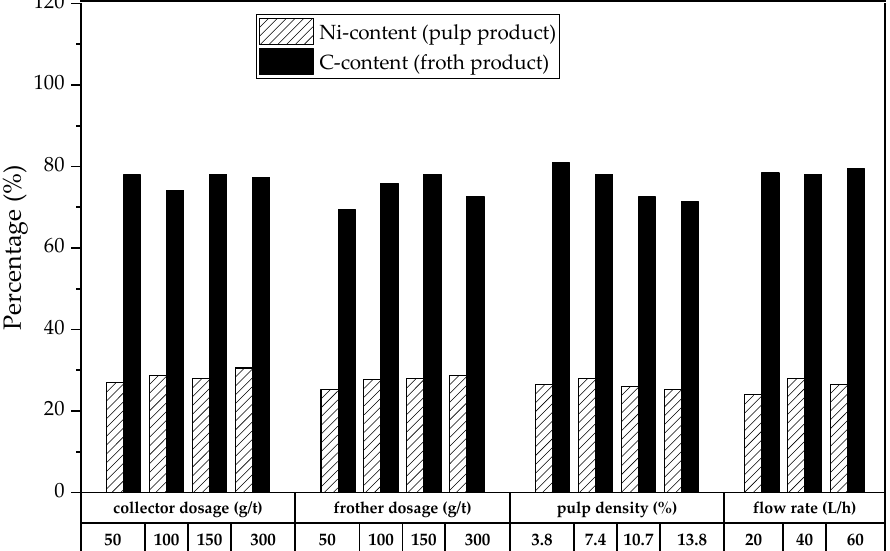
Figure 13. Effects of different flotation parameters on the grade of flotation products.